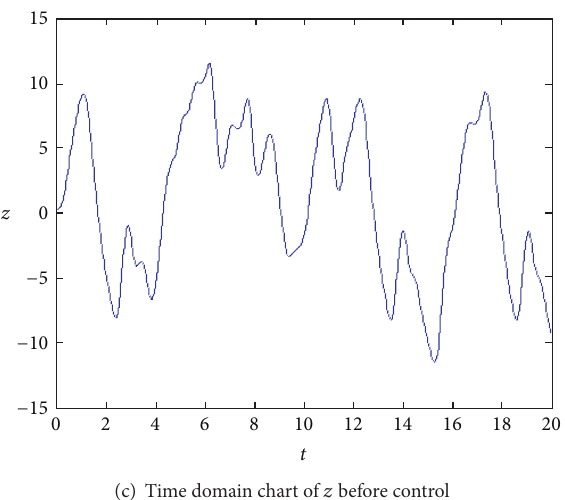
Figure 10: Time domain charts of state variables before